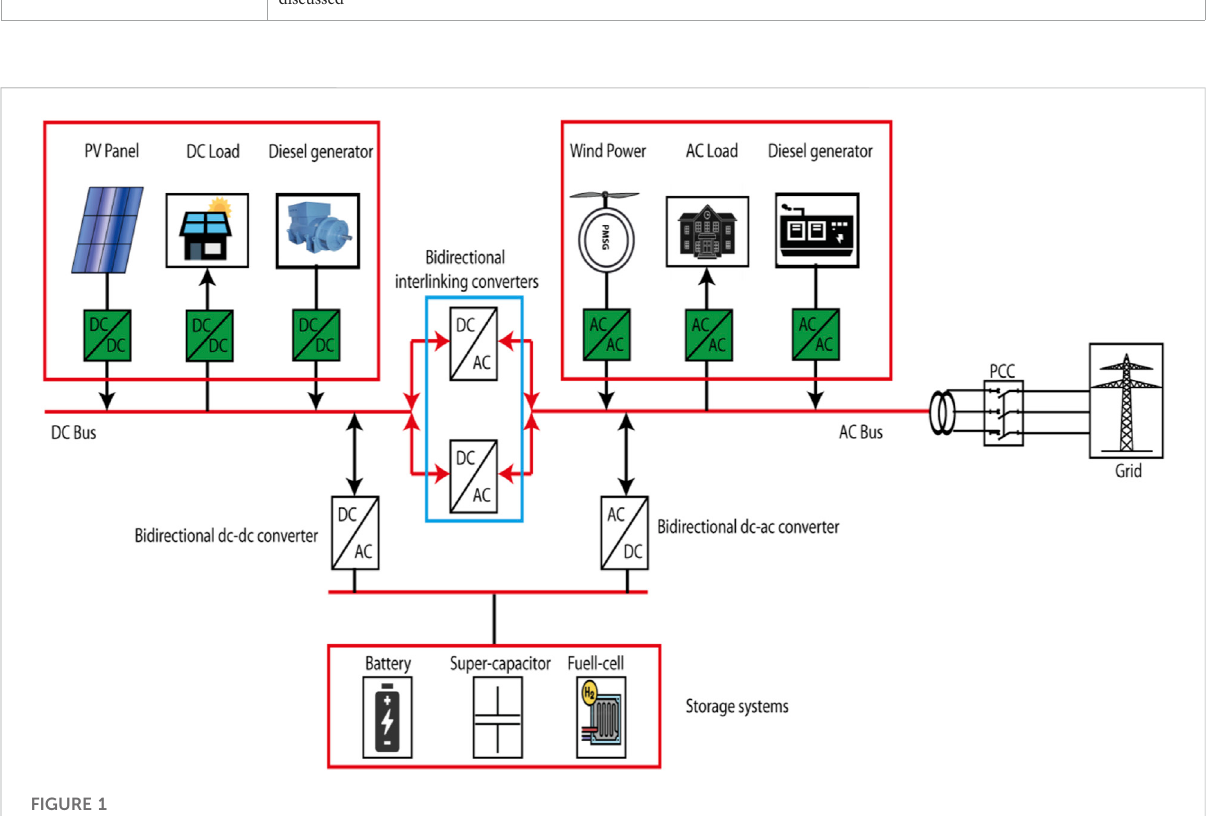
FIGURE 1 The microgrid